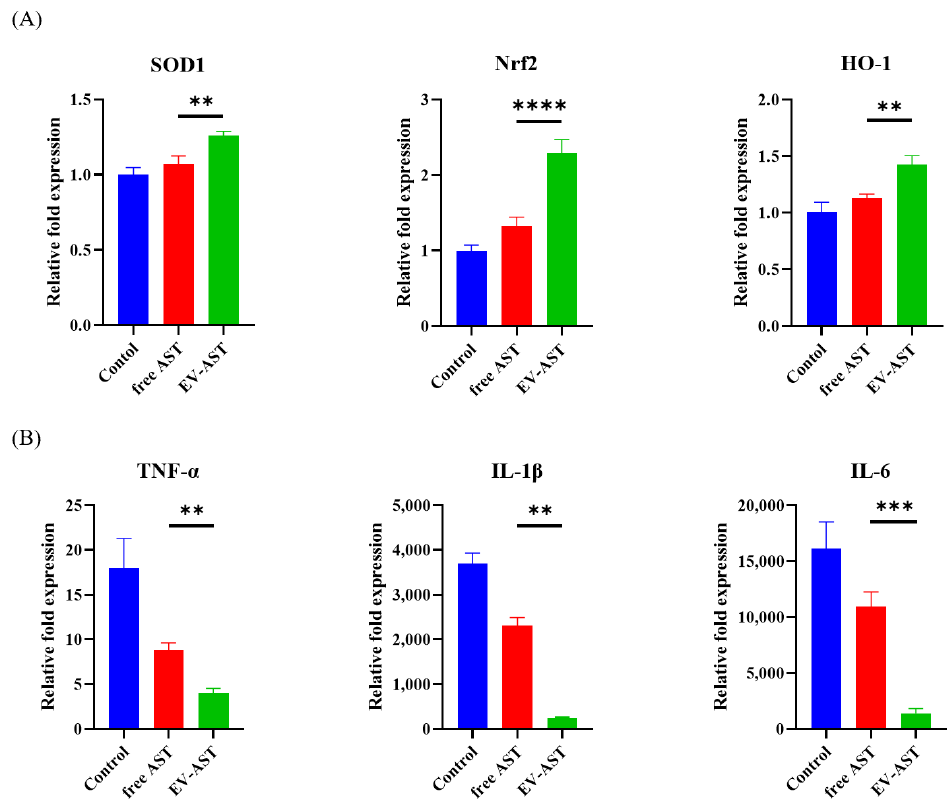
Figure 8. Determination of the altered expression of genes related to antioxidant and anti- inflammatory activities. Gene expression related to ( A ) antioxidant and ( B ) anti-inflammatory activities of free AST and EV-ASTs (0.8 µ g/mL) in HaCaT and LPS-stimulated RAW 264.7 cells, respectively (**: p < 0.01; ***: p < 0.001; ****: p <